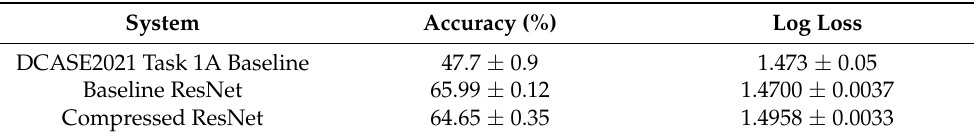
Table 6. Performance of the models on DCASE2021 Task 1A